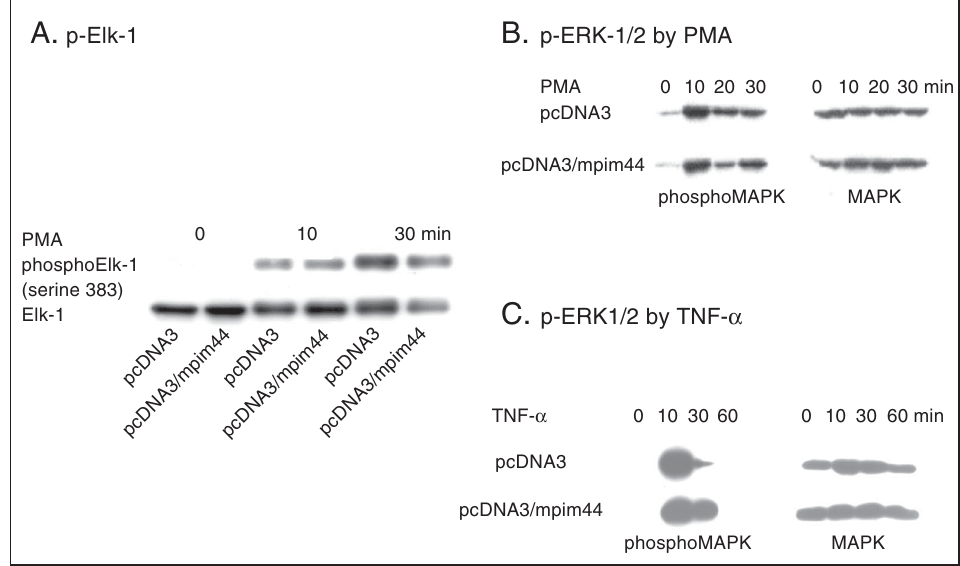
Figure 3. Pim-1 does not affect the phosphorylation and activation of ERK and Elk-1. A , Pim-1 does not inhibit the phosphorylation of Elk-1 at Ser383. HeLa cells were transfected with pcDNA3/Elk-1 and either pcDNA3 or pcDNA3/ pim-1. Cells were treated with phorbol myristate acetate (PMA) for the indicated times. Cell lysates were subjected to immunoblot analysis with anti-p-Elk-1 or anti-Elk-1 as indicated on the left side of each panel. Anti-Elk-1 recognizes both the phosphorylated and unphosphorylated Elk-1 while anti-p-Elk-1 specifically recognizes Elk-1 phosphorylated at Ser383. B , C , Pim-1 does not affect the phosphorylation of ERK. HeLa cells were transfected with either pcDNA3 or pcDNA3/pim-1. Cells were treated with PMA (B) or TNF- α (C) for the indicated times. Cell lysates were subjected to immunoblot analysis with anti-p-ERK (phosphoMAPK) or anti-ERK (MAPK) as indicated on the lower side of each panel. Anti-ERK recognizes both the phosphorylated and unphosphorylated ERK while anti-p-ERK